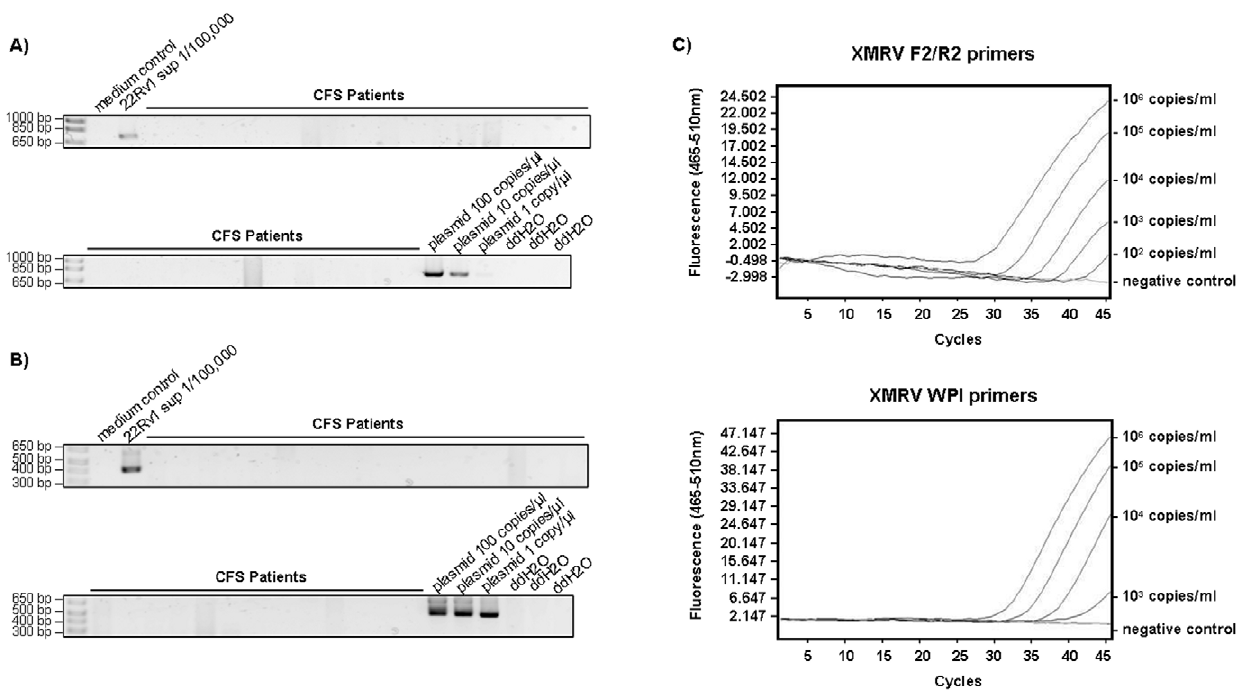
Figure 1. Failure of detection of XMRV nucleic acids in plasma and whole blood of CFS patients and healthy controls. A) First round PCR products of a representative number of RNA samples isolated from patient plasma using primers 419F and 1154R. A 10 2 5 dilution of 22Rv1 cell culture supernatant and three known concentrations of XMRV plasmid DNA were included as controls. B) Second round amplification products of nested PCR using primers Gag-I-F and Gag-I-R of samples shown in A). Identical results were obtained with primers NP116 and NP117 (see text, data not shown). The detection limit was below 1 copy/ m l isolated RNA or 5 copies/reaction. C) Results of qRT-PCR for XMRV plasmid control in serial dilutions ranging from 10 6 to 10 2 copies/ml as well as negative controls for both primer pairs used, F2/R2 (upper panel) and WPI (lower panel). All patient plasma and whole blood samples were found to be negative after a total of 45 amplification cycles (data not shown).